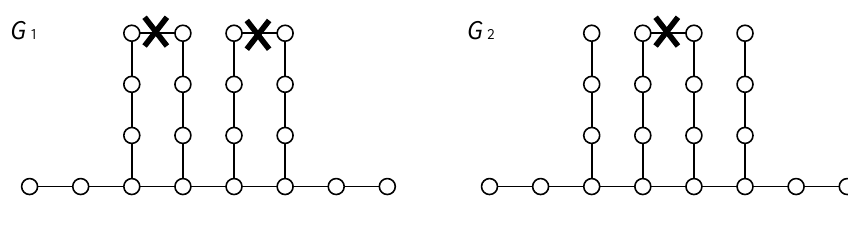
Figure 5. Example of a difficult case.